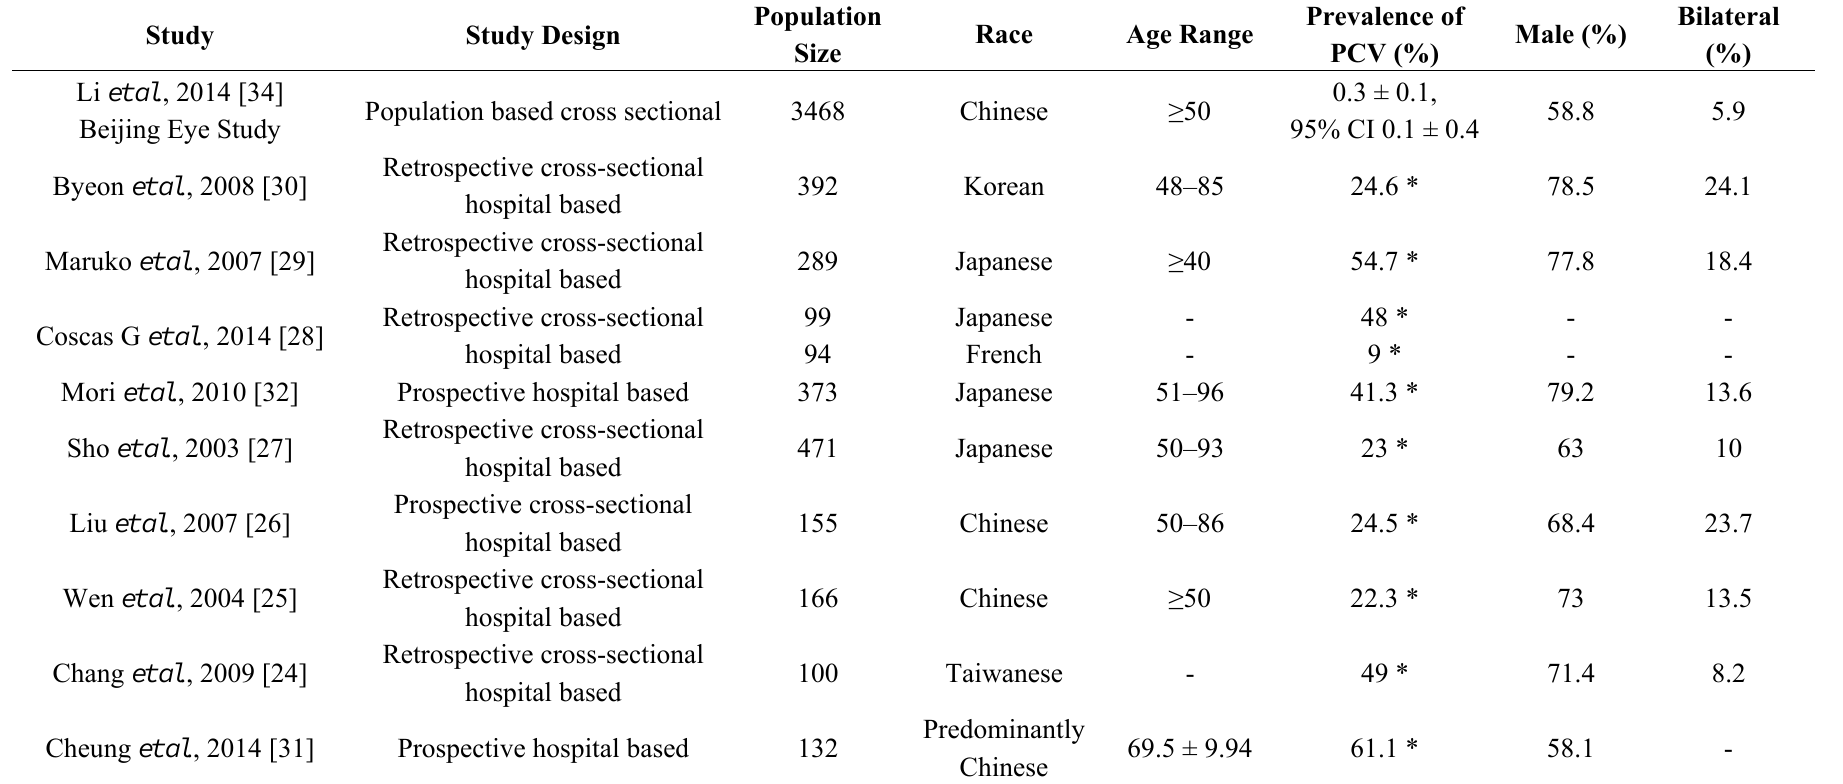
Table 1. Epidemiological studies of polypoidal choroidal vasculopathy in